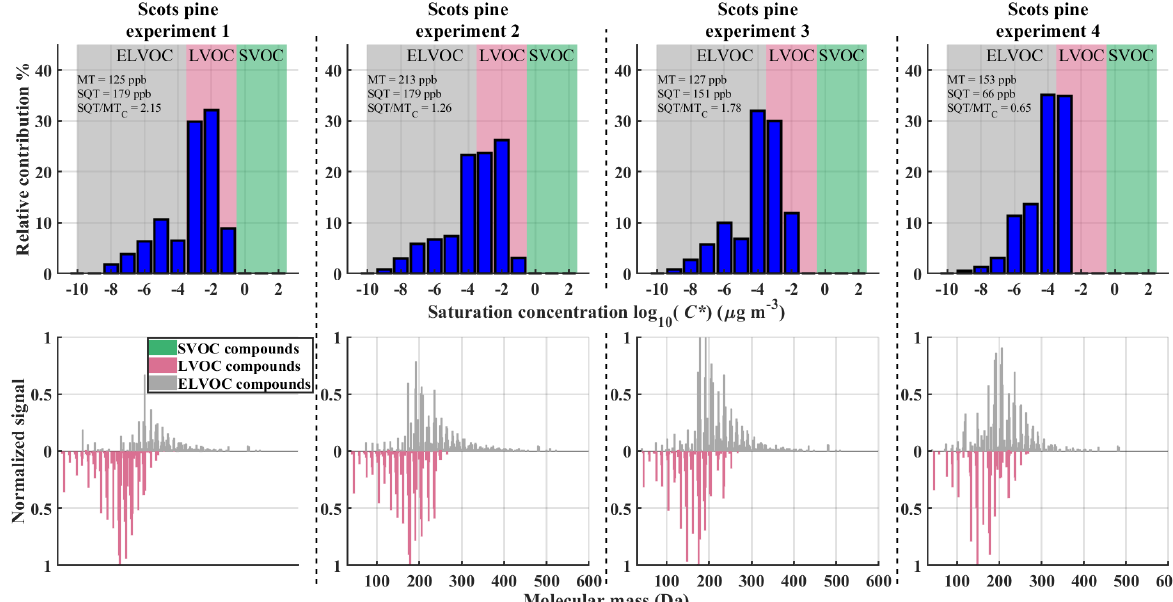
Figure 7. VBS bins and corresponding normalized integrated mass spectra in the Scots pine experiments. Top row: VBS bins determined from T max with background colours corresponding to different volatility classes. Bottom row: integrated FIGAERO signal normalized to maximum signal coloured by corresponding volatility class. LVOC class is plotted on reverse y axis to more easily distinguish them from other volatility classes. Text in the upper row panels shows measured amounts of monoterpenes and sesquiterpenes and calculated SQT / MT ratio per mass